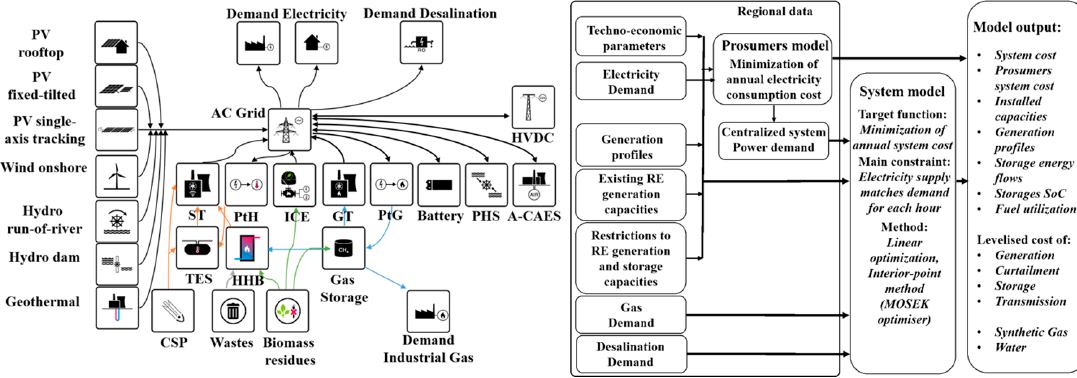
Figure 2. Block diagram of the energy system model ( left ); and the model flowchart ( right ) for Southeast Asia [45]. ST: steam turbine; PtH: power-to-heat done by heating rod; ICE: internal coombustion engine; GT: gas turbine; PtG: power-to-gas; PHS: pumped hydro storage; HVDC: high voltage direct current; A-CAES: adiabatic compressed air energy storage; TES: thermal energy storage; HHB: hot heat burner; and CSP: concentrating solar thermal power.